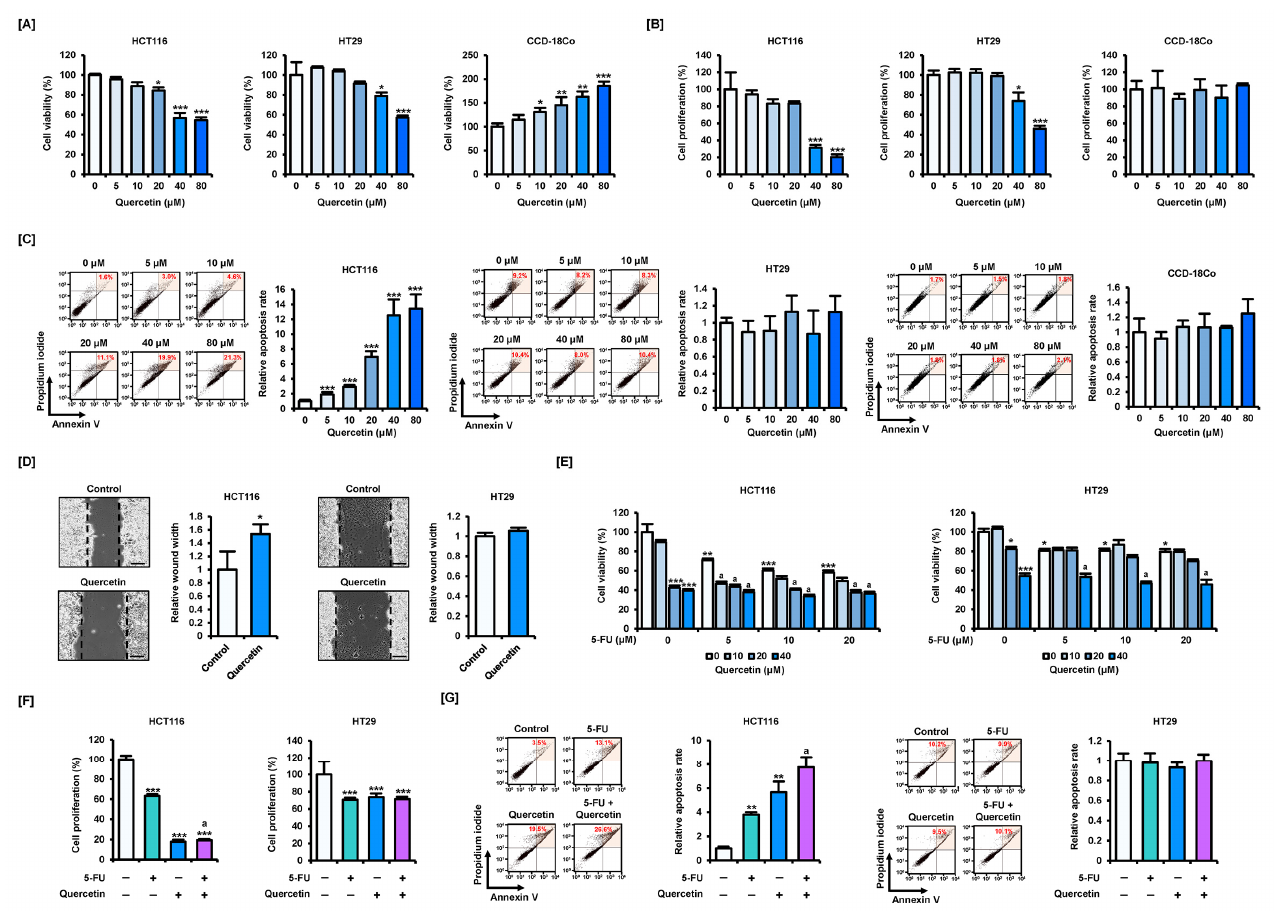
Figure 1. Effects of quercetin on the viability and proliferation of colorectal cancer (CRC) cells. ( A ) Dose-dependent effects of quercetin (0, 5, 10, 20, 40, and 80 µ M) on the viability of HCT116, HT29, and CCD18-Co cells over 48 h. ( B ) Dose-dependent effects of quercetin (0, 5, 10, 20, 40, and 80 µ M) on the proliferation of HCT116, HT29, and CCD18-Co cells over 48 h. ( C ) Dose-dependent effects of quercetin (0, 5, 10, 20, 40, and 80 µ M) on apoptosis of HCT116, HT29, and CCD18-Co cells over 48 h. Annexin V and propidium iodide (PI) fluorescence values were estimated by flow cytometry. The percentage of cells corresponding to the upper right of the quadrant was used to compare the relative number of apoptotic cells. ( D ) Effects of quercetin (40 µ M) on the migration of HCT116 and HT29 cells over 12 h. Scale bar represents 100 µ m. ( E ) Effects of dose-dependent combination treatment of 5-fluorouracil (5-FU, 0, 5, 10, and 20 µ M) and quercetin (0, 10, 20, and 40 µ M) on viability of HCT116 and HT29 cells over 48 h. ( F ) Effects of 5-FU (20 µ M) and quercetin (40 µ M) combination treatment on proliferation of HCT116 and HT29 cells over 48 h. ( G ) Effects of 5-FU (20 µ M) and quercetin (40 µ M) combination treatment on apoptosis of HCT116 and HT29 cells over 48 h. Annexin V and PI fluorescence values were estimated by flow cytometry. The percentage of cells corresponding to the upper right of the quadrant was used to compare the relative number of apoptotic cells. Data are presented as representatives of the results of three independent experiments. Asterisk indicates a statistically significant difference compared with untreated control cells (*** p < 0.001; ** p < 0.01; * p < 0.05). The symbol ‘a’ indicates a significant effect of the combination treatment compared with the treatment with 5-FU alone ( p <